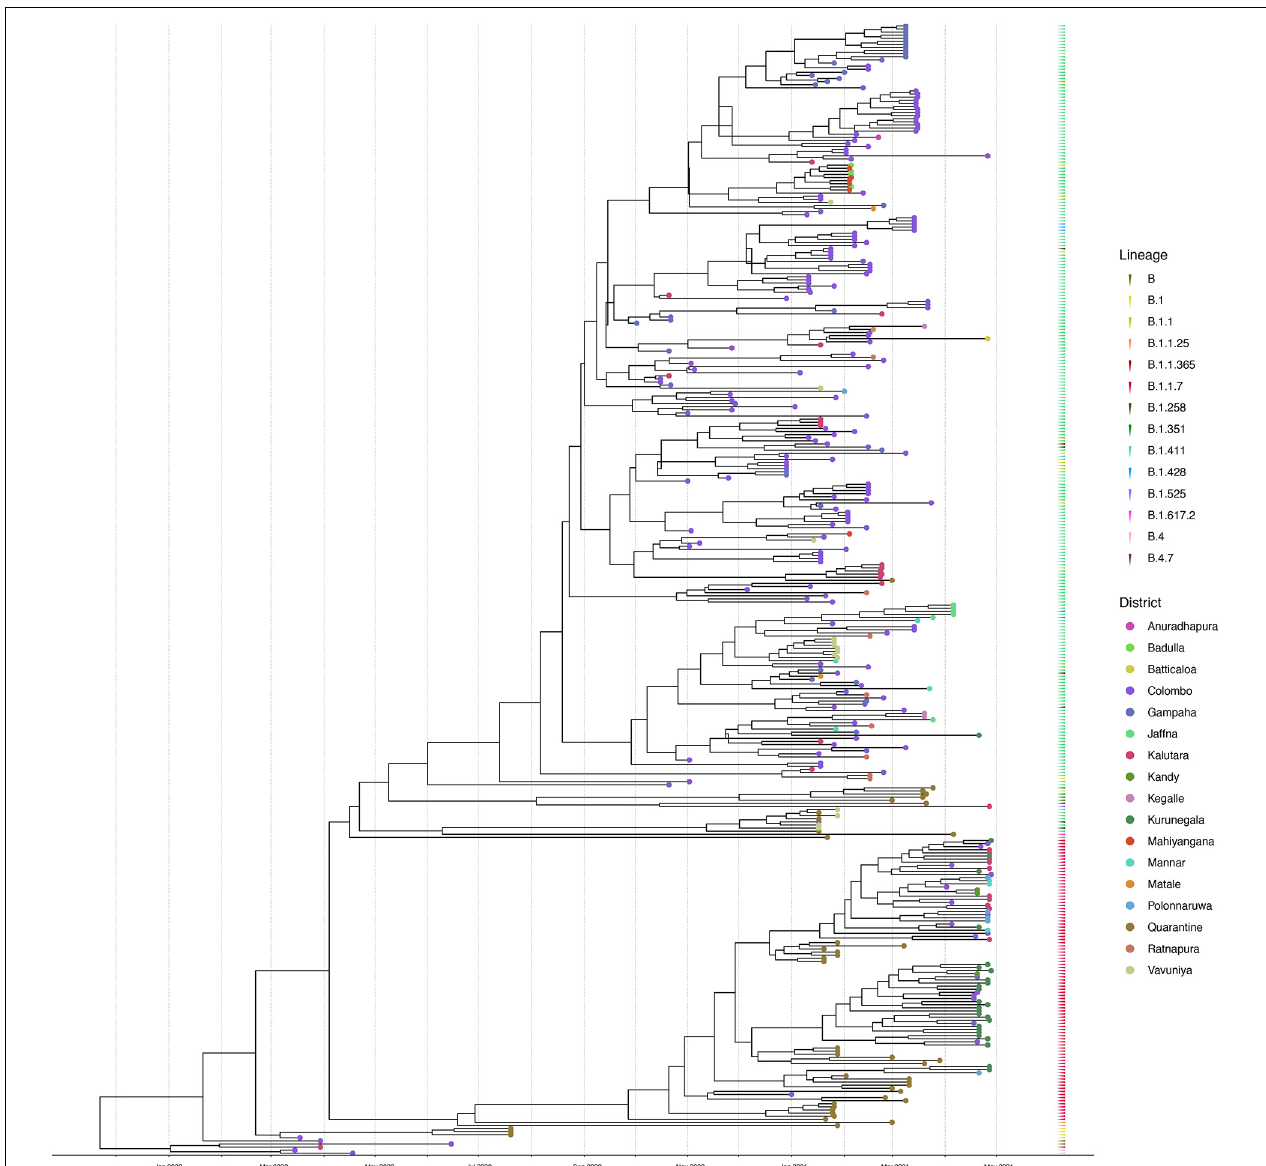
FIGURE 4 | Bayesian time-scale phylogeny of Sri Lankan samples. Tips are coloured by the sample location, and the external layer on the right shows the sample lineages. The molecular clock was inferred using BEAST with HKY evolution model and a relaxed molecular clock (initial evolutionary rate was set to 0.001 substitutions/site/year). See Supplementary Figure 1 for the Bayesian tree with all posterior support